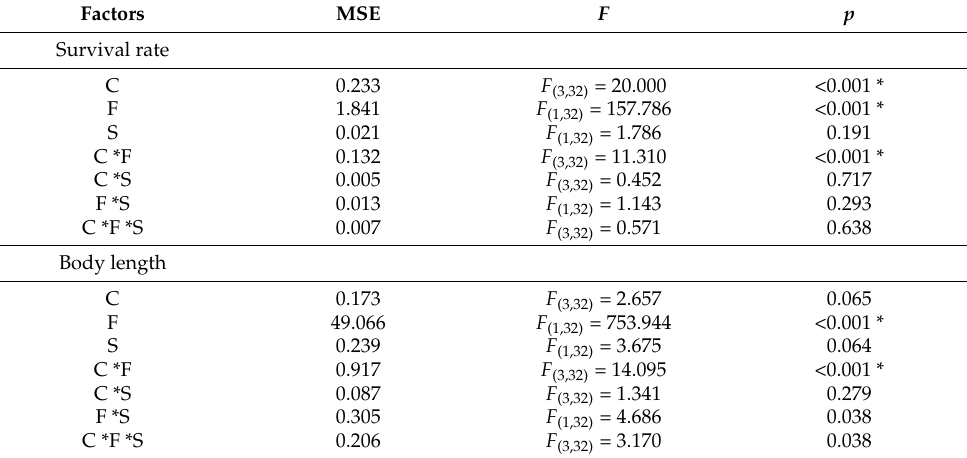
Table 1. Three-way ANOVA summary on the effects of exposure concentrations (C) and size (S) of PS-NH 2 , as well as food level (F), on survival rates (%), body length (mm), and instar of A. parthenogenetica . Exposure concentrations of PS-NH 2 : 0, 5.5, 55, and 550 µ g/L; food level: low food level, high food level; Size: 50 nm, 1 µ m; MSE: mean squared